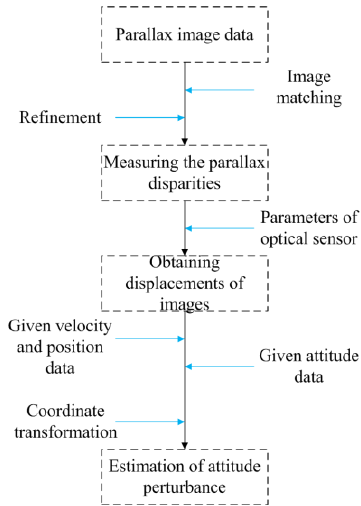
Figure 1. Schematic view of estimating the attitude perturbance in this